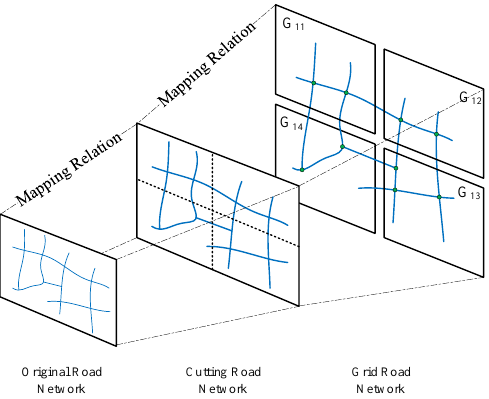
Figure 2. Schematic diagram of grid road network division.